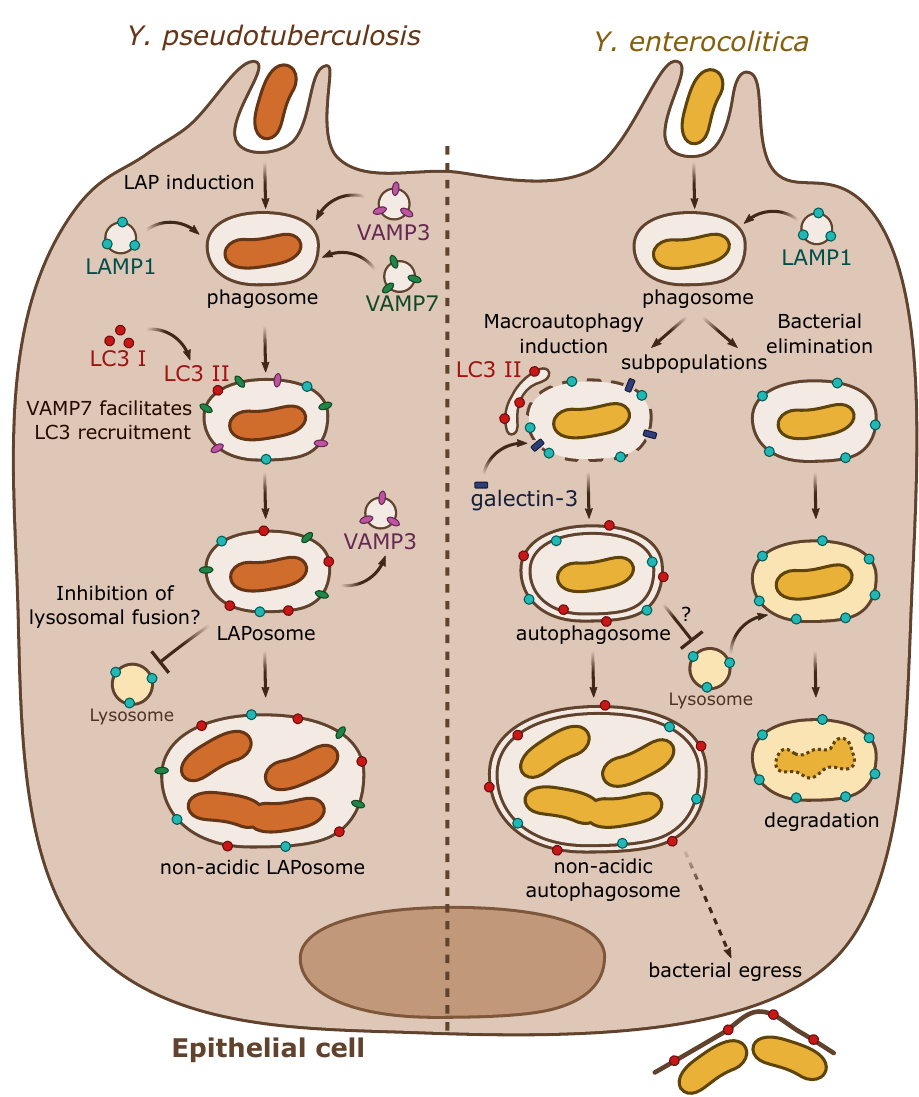
Figure 2. Summary results from independent studies of autophagy subversion by enteropathogenic Yersinia in epithelial cells. Y. pseudotuberculosis (left) activates the LAP autophagic pathway during epithelial infection. VAMP3 and VAMP7 are sequentially targeted to the phagosome. VAMP3 favors the commitment towards a single-membrane compartment. VAMP7 participates to the recruitment of LC3-II directly to the phagosome forming the LAPosome. Y. pseudotuberculosis survives and multiplies within a non-acidic single membrane LAPosome. Y. enterocolitica (right) can survive or be degraded in epithelial cells. A subpopulation follows the lysosomal degradative pathway whereas the rest activates the macroautophagy pathway by recruiting LC3-positive autophagic membranes. Galectin-3, a marker of damaged endomembrane, is also recruited to some YCVs, suggesting their potential